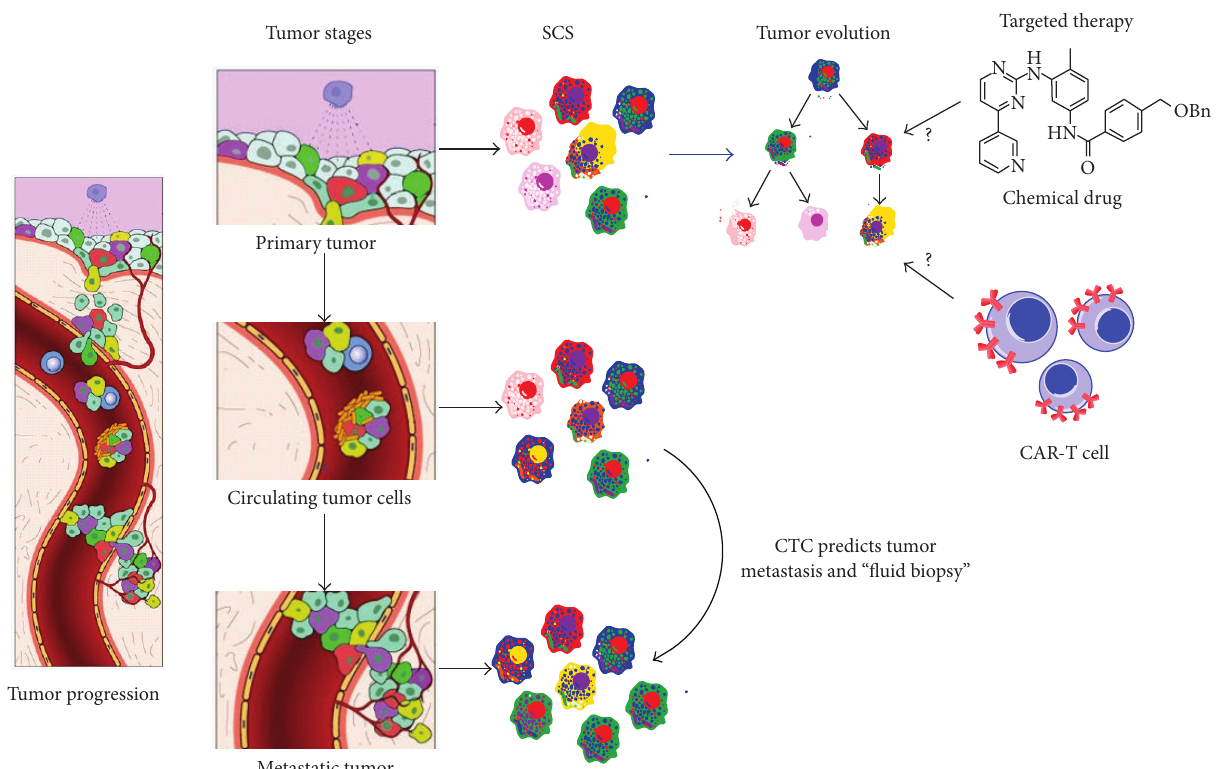
Figure 2: Application of single-cell sequencing technology in tumor evolution and metastasis. In tumor progression, some tumor cells at the primary site can invade into the basement of blood vessels, migrate into the blood circulation, and then implant in the distant tissue site, defined as metastasis. Circulating tumor cells (CTCs) can be easily collected and single-cell sequencing of CTC can be used to predict tumor metastasis. Determining the driver gene mutations of cellular subpopulations may aid in understanding on the tumor evolution and the development of targeted therapy using chemical drugs and immune cell therapies, such as chimeric antigen receptor modified-T cells (CAR-T